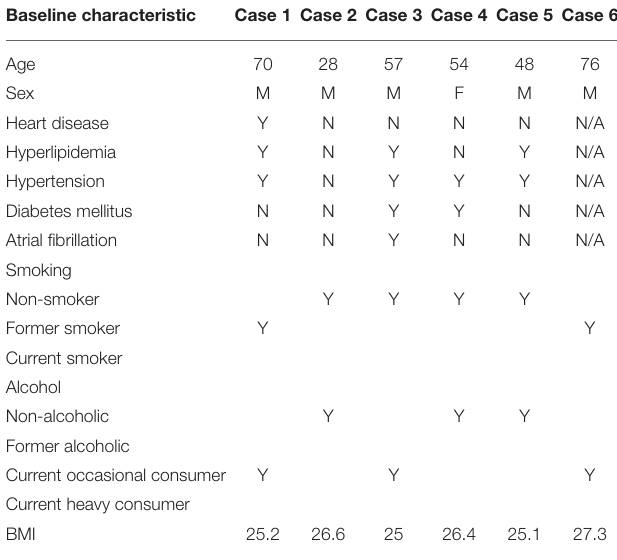
TABLE 1 | Baseline